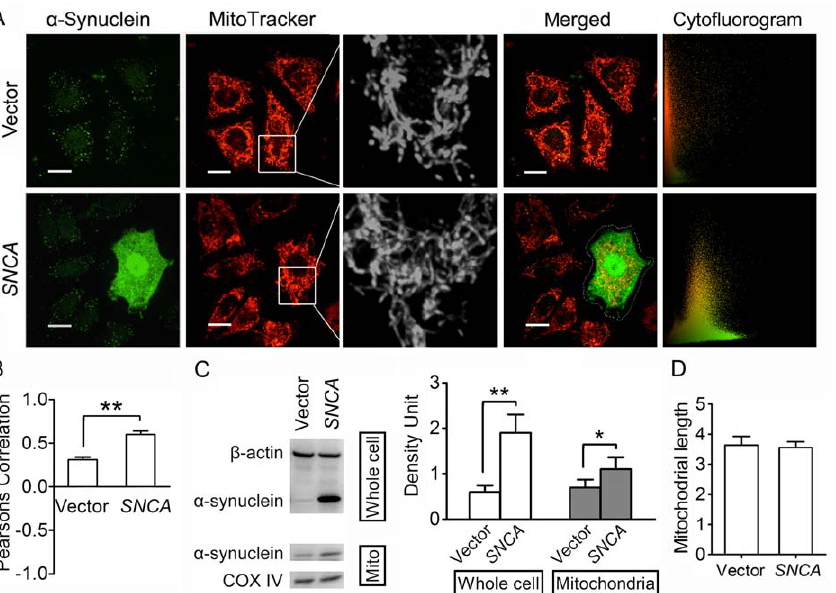
Figure 4. a -Synuclein overexpression increases its localization on mitochondria without causing mitochondrial fragmentation in PC12 cells. A. Representative double-staining images of a -synuclein (Green) and mitochondria (Red) in PC12 cells transfected with SNCA or an empty vector for 48 h. Amplified images clearly demonstrate that no perceptible alteration in mitochondrial morphology between these two groups. Cytofluorogram analysis shows that PC coefficient of that a -synuclein overexpressed cell (PC=0.574982, CC Mx=0.972038, CC My=0.98707) is much higher than Vector group (PC=0.316512, CC Mx=0.962559, CC My=0.439231). Scale bars for 10 m m. B. Quantitative analysis shows that PC coefficients in SNCA group are remarkably elevated compared with Vector group. C. Immunoblotting assay shows that a -synuclein expression levels in PC12 cell lysates and mitochondrial lysates are both significantly increased after SNCA transfection for 48 h (n=4). D. Quantitative analysis of changes in mitochondrial length shows no significant statistic difference between SNCA group and Vector group. Images of 20 cells from each group were processed for cytofluorogram (B) and mitochondrial morphology analysis (D), and the experiment was repeated three times. *P , 0.05, **P , 0.01.